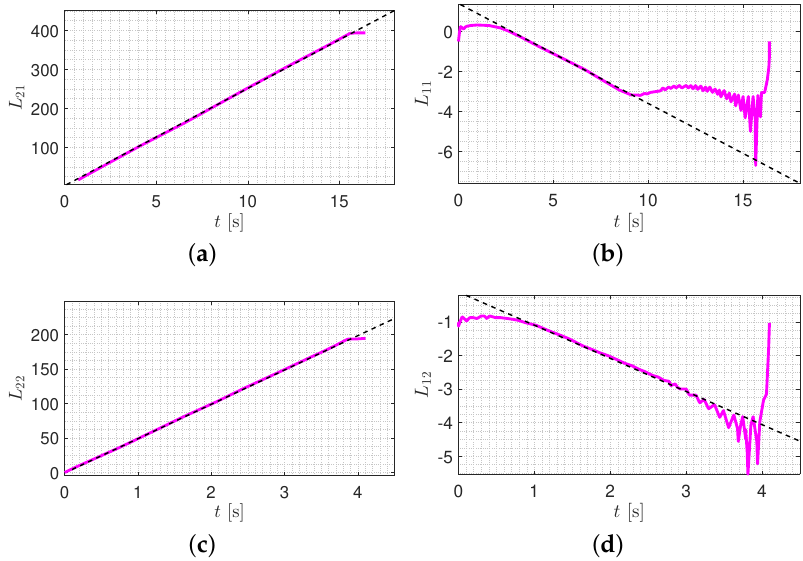
Figure 13. Curve fitting to obtain the modal parameters of first mode, i = 1 (first row), and second mode, i = 2 (second row). ( a ) L 21 ; linear fit: L 21 = 24.93 t + 2.089; ( b ) L 11 ; linear fit: L 11 = − 0.5 t + 1.4; ( c ) L 22 ; linear fit: L 22 = 49.76 t − 0.5955; ( d ) L 12 ; linear fit: L 12 = − 0.988 t − 0.1084. Table 2. Comparison of identified modal parameters with corresponding Finite Element (FE) results. Finite Element Model Mode